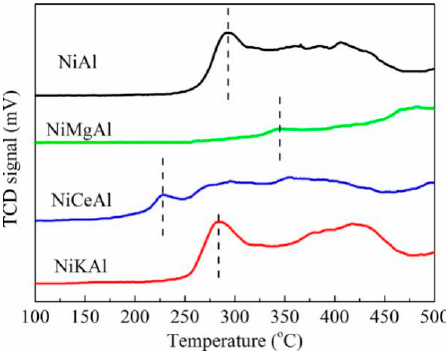
Figure 3. H 2 -TPR spectrum of fresh catalyst. Reproduced with permission from [61], Copyright 2018, Elsevier.